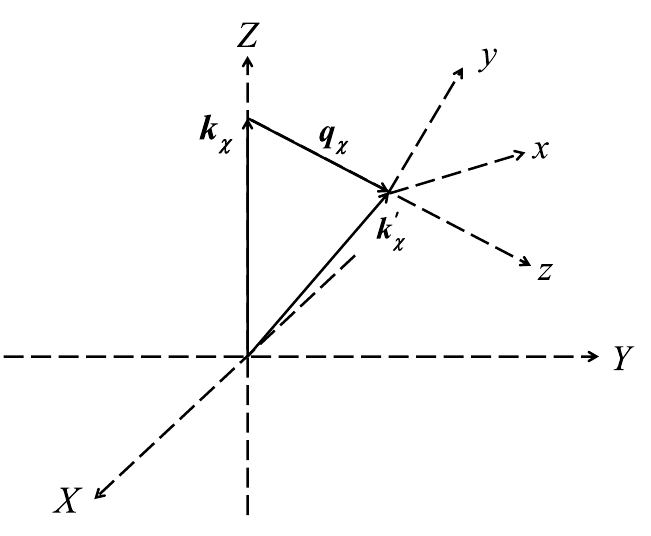
Figure 3 . In the atomic ionization process induced by millicharged particles, the coordinate systems XY Z and xyz are chosen similar to the cases in atomic Compton scattering (in figure 2). The coordinate system XY Z is chosen such that the Z axis is along the direction of initial momentum k χ for millicharged particle, and X axis can be chosen as arbitrary direction perpendicular to the Z axis. The momentum for the scattered millicharged particle is denoted as k 0 transfer vector q in atomic ionization process is defined as q χ axis z represents the momentum transfer